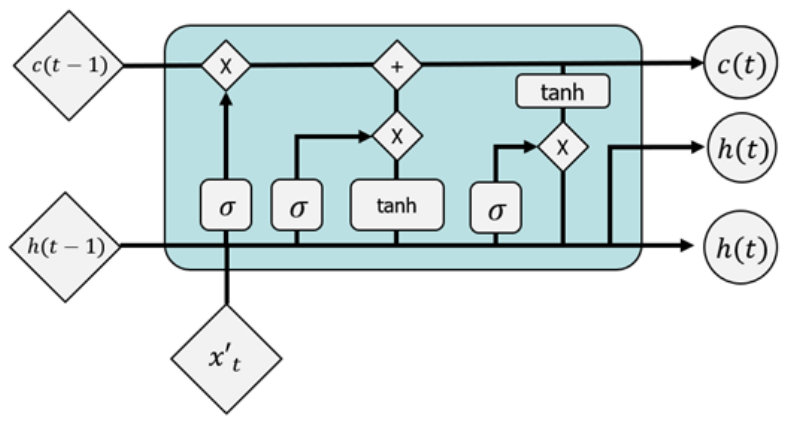
Figure 4. Basic Architecture Long Short-Term